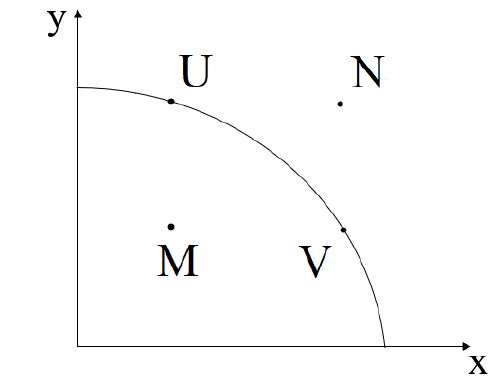
Figure 16. Schematic diagram of the Pareto